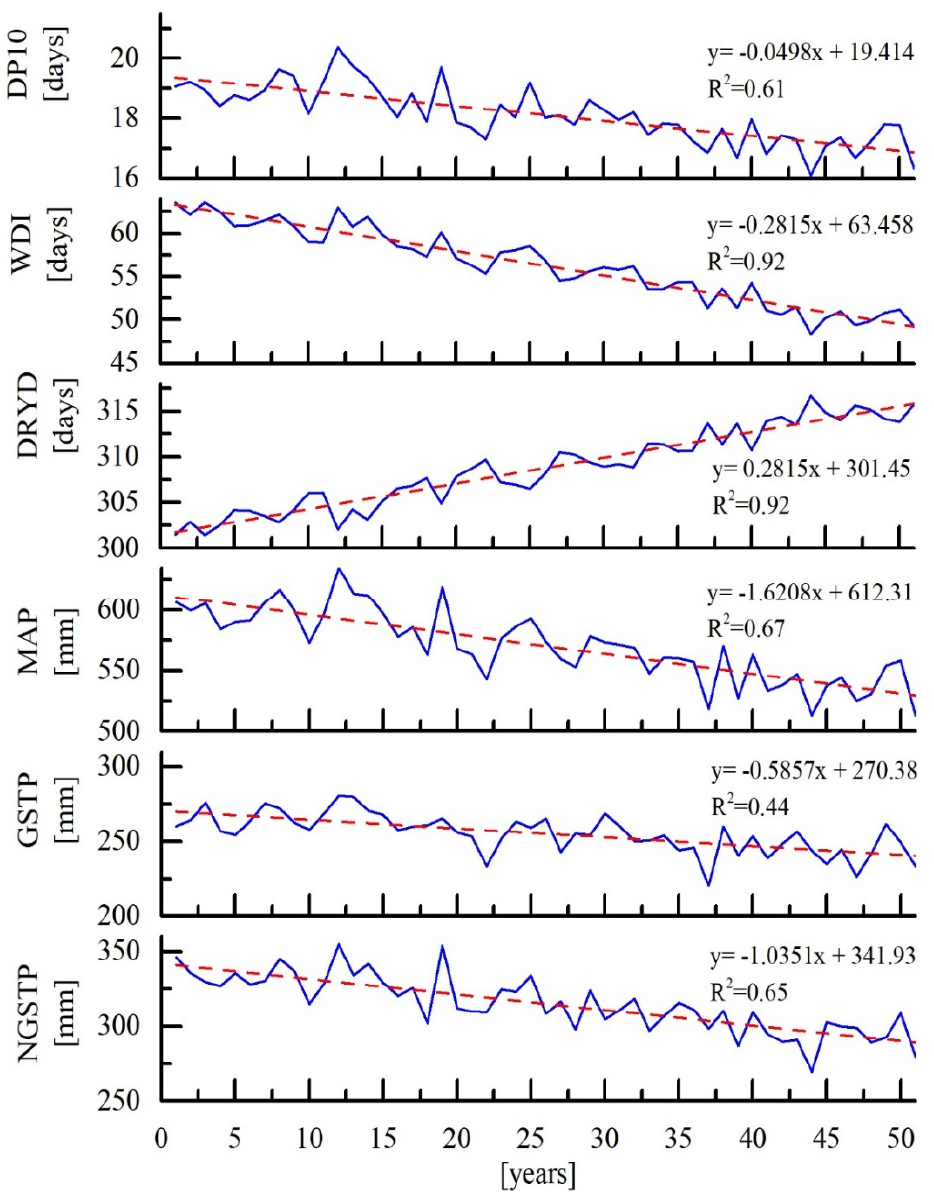
Figure 4. Transient analysis: trend of the investigated rainfall metrics, averaged from 500 STORAGE realizations.